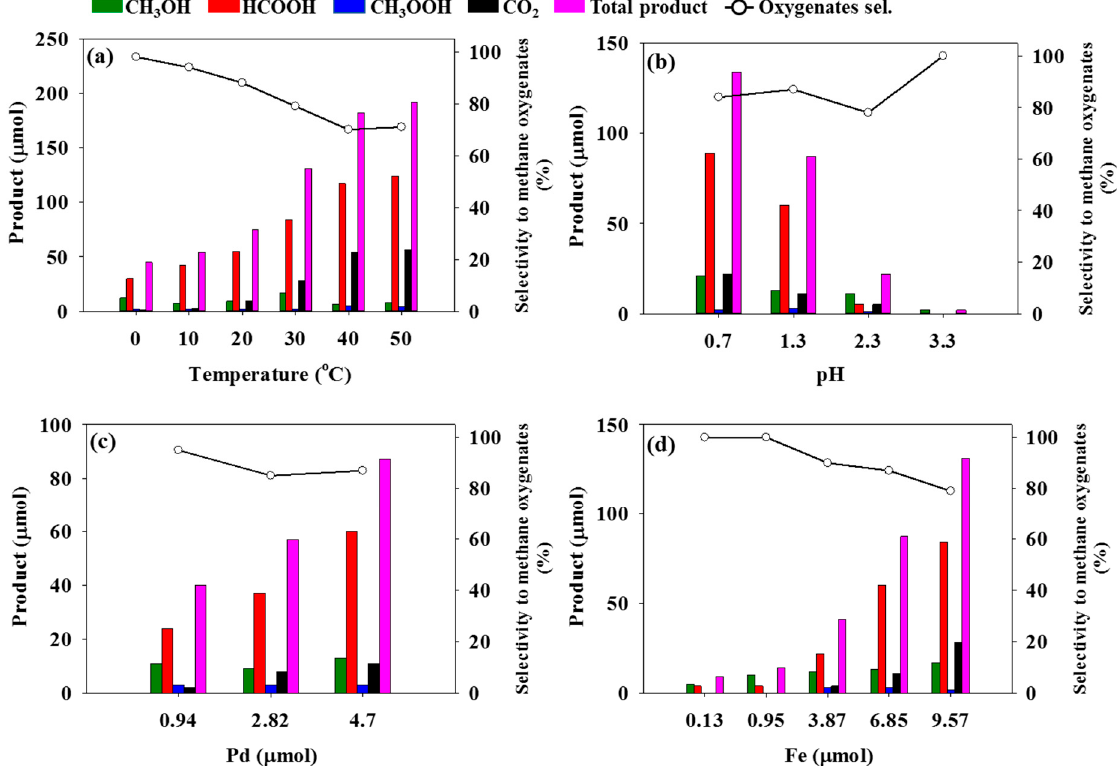
Figure 2. Performance of Fe-ZSM-5 catalysts such as 1.07 wt. % Fe-ZSM-5 ( a ), 0.766 wt. % Fe-ZSM-5 ( b , c ), and Fe-ZSM-5 with various Fe content ( d ) for partial oxidation of methane in the presence of H 2 and O 2 and 1 wt. % Pd/AC. Reaction conditions: 50 mg of Fe-ZSM-5 and 50 mg of 1 wt. % Pd/AC were used in all cases except for ( c ). Different amounts of Pd/AC were used for the case ( c ); reaction time = 30 min. V liquid = 30 mL, V gas = 90 mL, P CH4 = 15 bar, P H2 = 3 bar, P Air = 10 bar. The reaction temperature was fixed at 30 °C in all cases except for ( a ). The concentration of H 2 SO 4 was 15 mM in all cases except for ( b ).